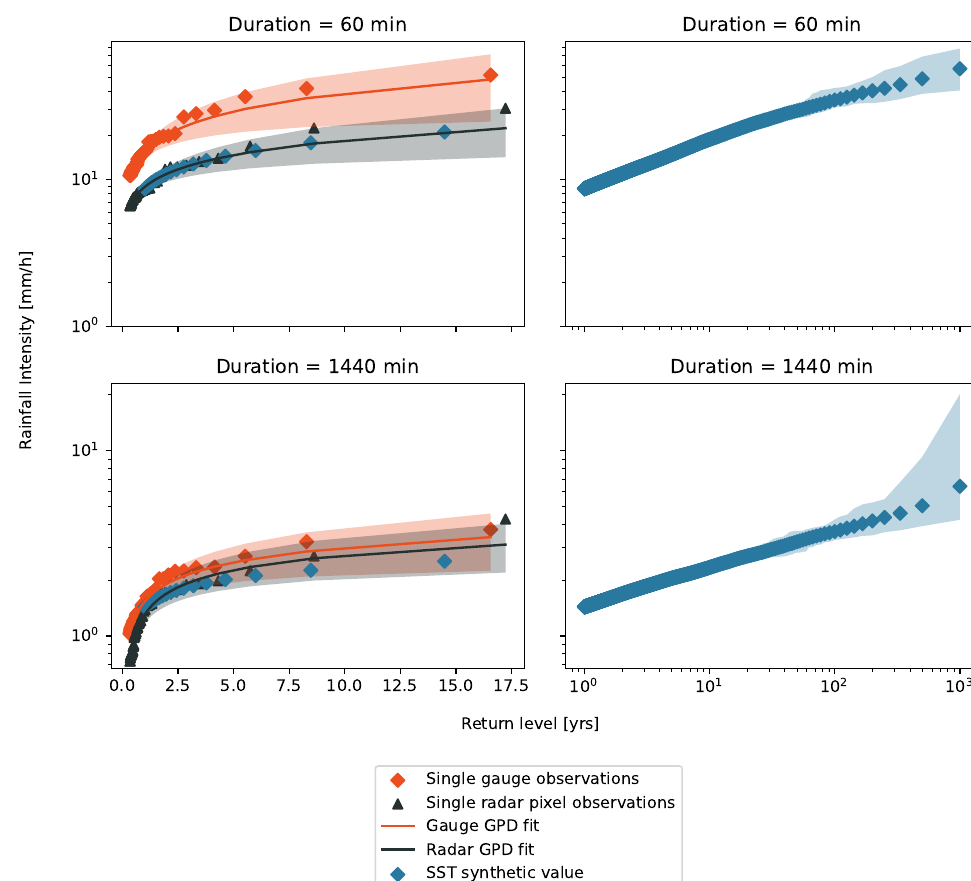
Figure 4. GPD-based frequency analysis for long-term gauge (orange) and the corresponding radar pixels (black). The lines indicate the fitted GPD-model and shaded area depicts model uncertainty. Ranked values of synthetic rainfall years generated by the SST procedure are also shown (blue). Due to the high density of points, only every 50th SST point is shown on the figures to the left.